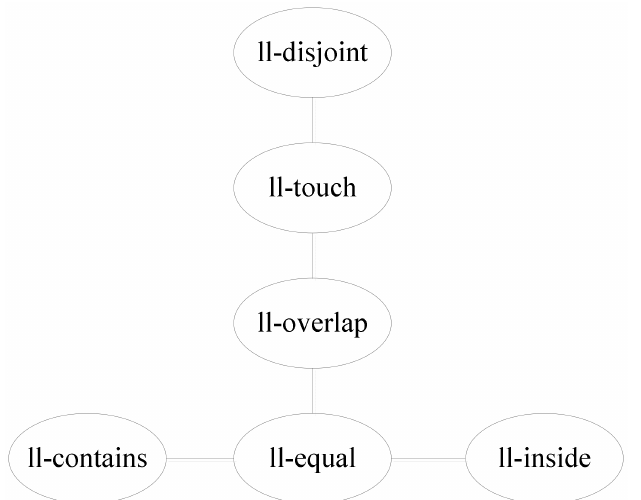
Figure 10. Conceptual neighborhood diagram of topological relations between two line segments. Table 5. Topological relation distances between two line segments.